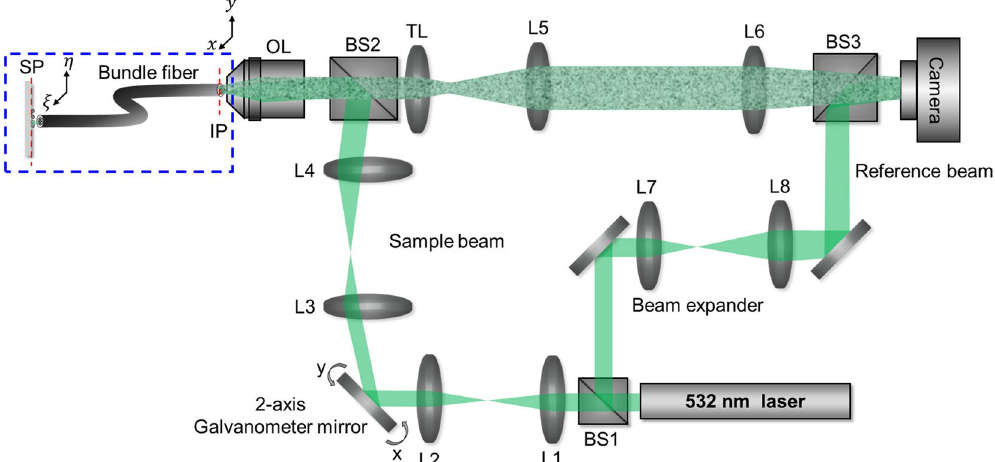
Figure 2. Schematic layout of the experimental setup. Interference microscope with a 2-axis scanning mirror installed in the sample bream path. A target object is placed at the SP. For clarity, the spatial coordinates at IP and SP are denoted as ( x,y ) and ( ξ , η ). BS1-3: beam splitters, L1-8: lenses, OL: objective lens, TL: tube